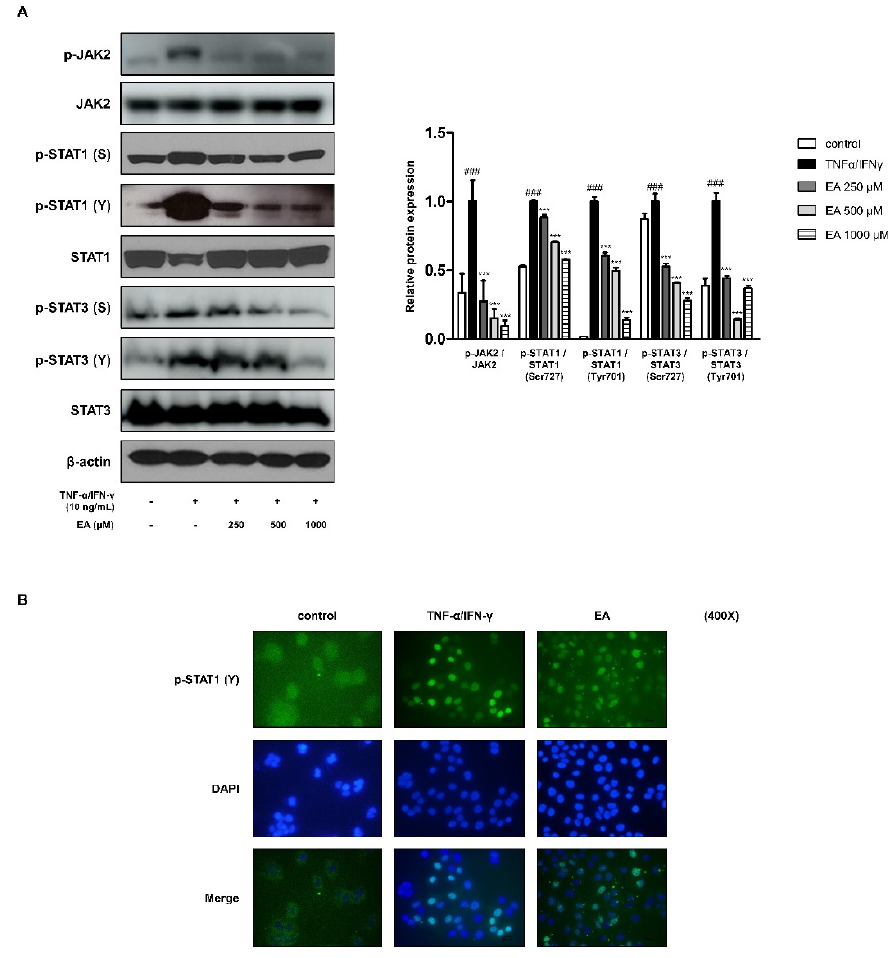
Figure 3. Effects of EA on Janus kinase (JAK)/STAT signaling pathways in activated HaCaT keratinocytes. Cells were treated with 250, 500, or 1000 μ M of EA for 1 h prior to the addition of TNF- α /IFN- γ and were incubated for 1 h. ( A ) Phosphorylation of JAK2, STAT1, and STAT3 was determined by western blot assay. The graph shows the ratio of phosphorylated JAK2, STAT1, and STAT3 to total JAK2, STAT1, and STAT3, respectively. ( B ) Translocation of phosphorylated STAT1 (Y) was visualized by immunofluorescence. The nuclei were counterstained with DAPI (blue). The stained cells were visualized with a fluorescence microscope at 400× magnification. Values represent the mean ± standard error mean (SEM) of triplicate independent experiments ( n = 3). *** p < 0.001 versus the only TNF- α /IFN- γ -treated group, ### p < 0.001 versus the control group by ANOVA and Dunnett’s post-hoc test.